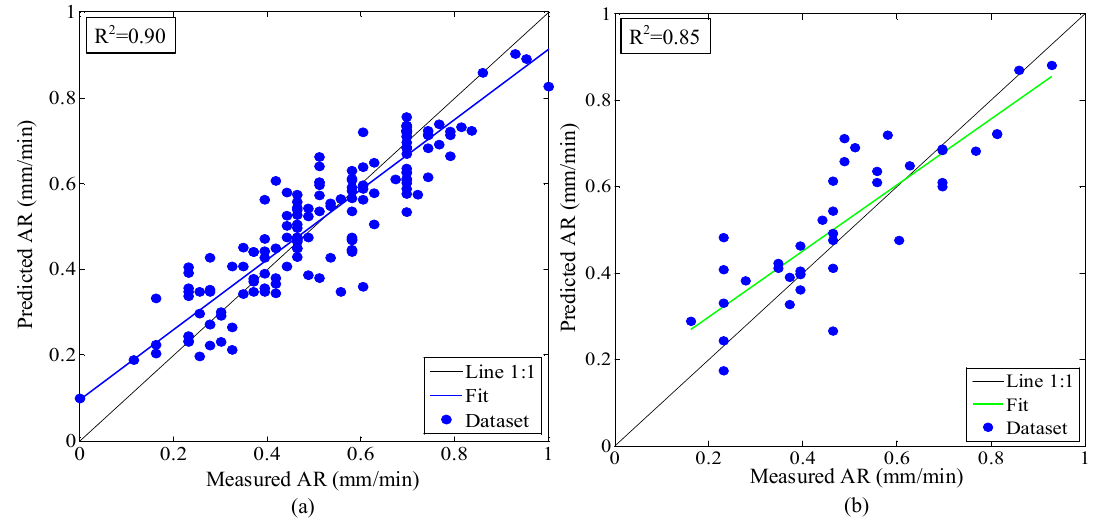
Figure 9. Comparison between measured and predicted AR from the ANFIS-GA model: ( a ) training set and ( b ) testing set. Table 4. The relative deviation of the hybrid ANFIS-GA model.